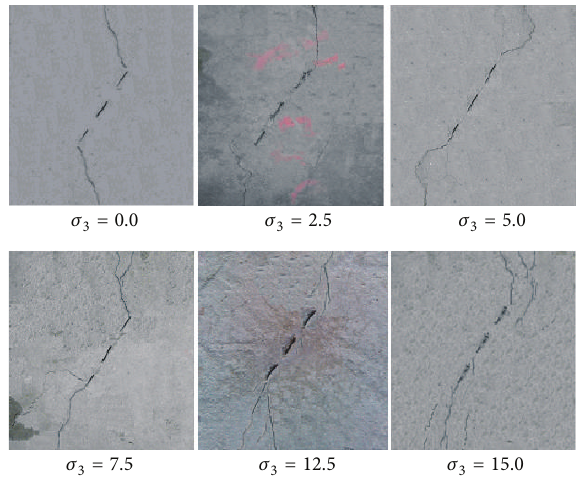
Figure 3: Fracture patterns under different confining stress.